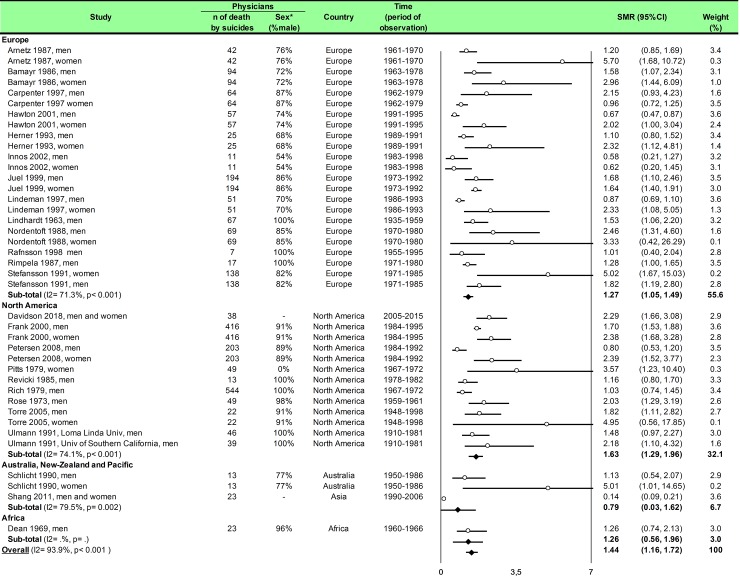
Meta-analysis of standardized mortality rate for suicides by geographic zones.